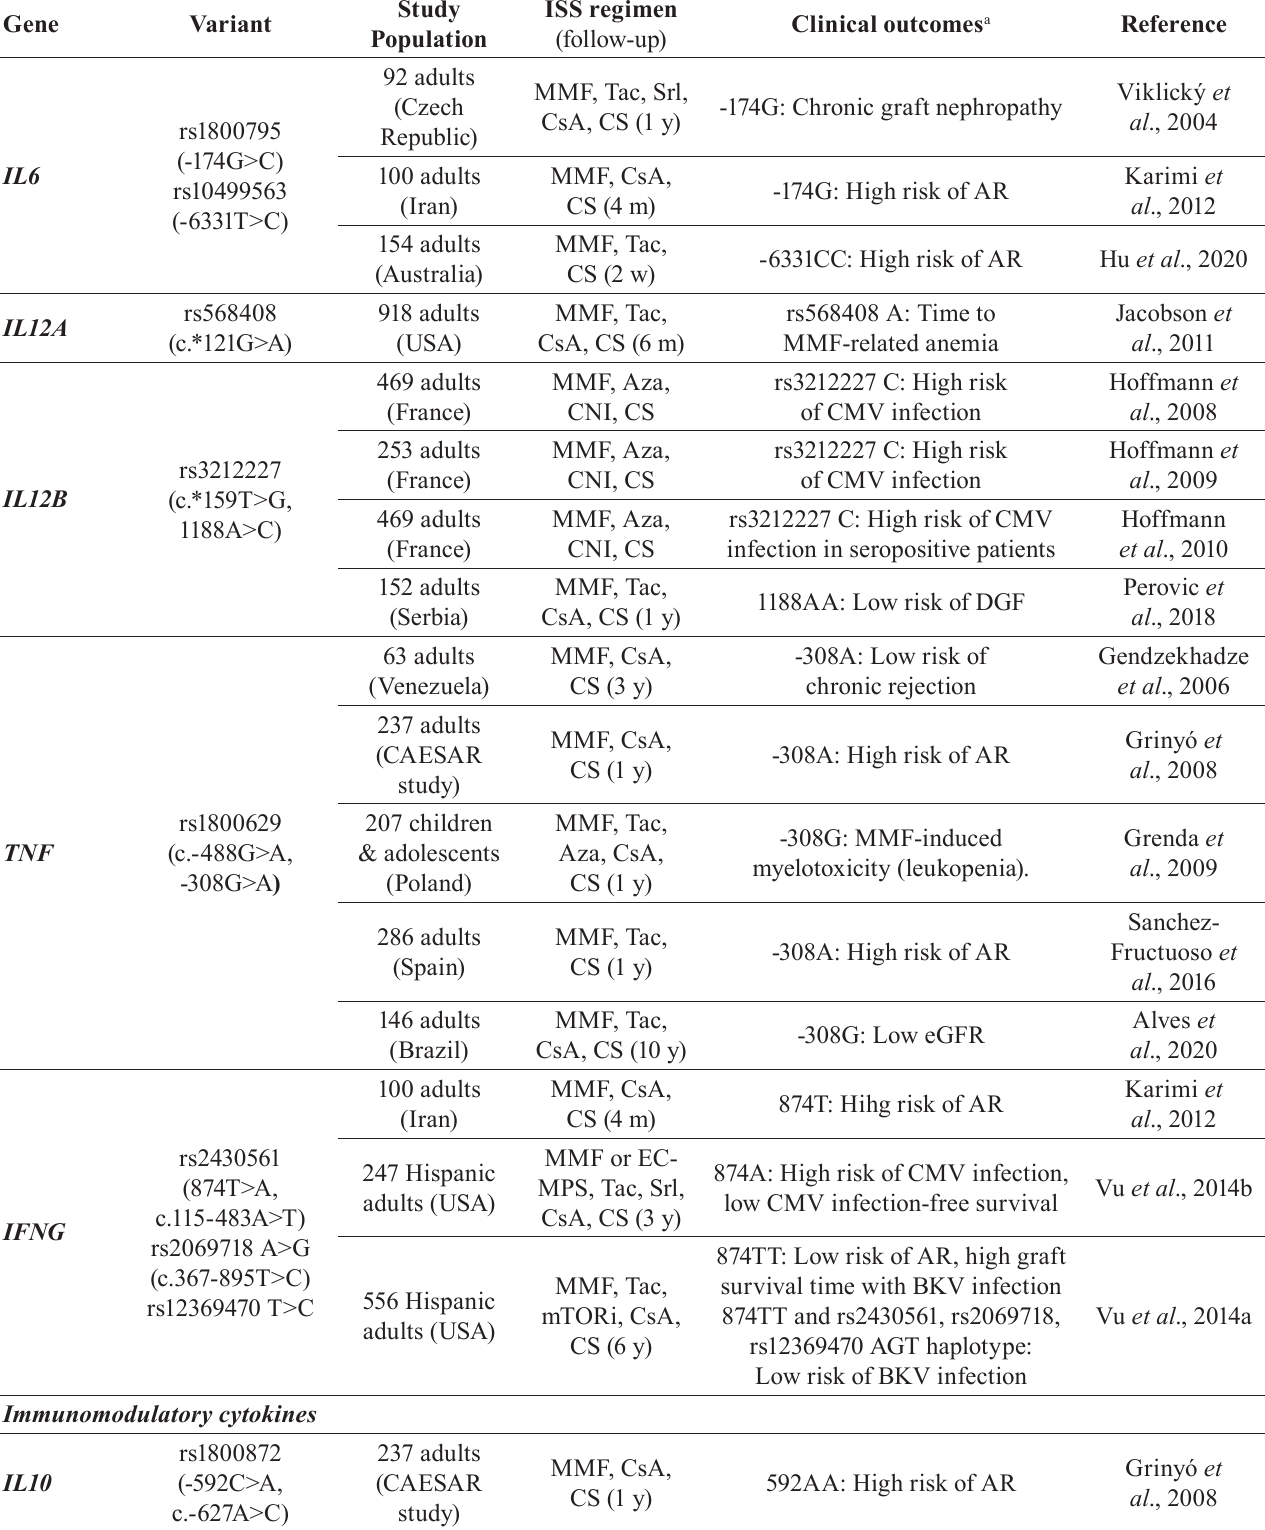
TABLE III - Genes related to cytokines and immune innate response in kidney recipients on MPA therapy with significant